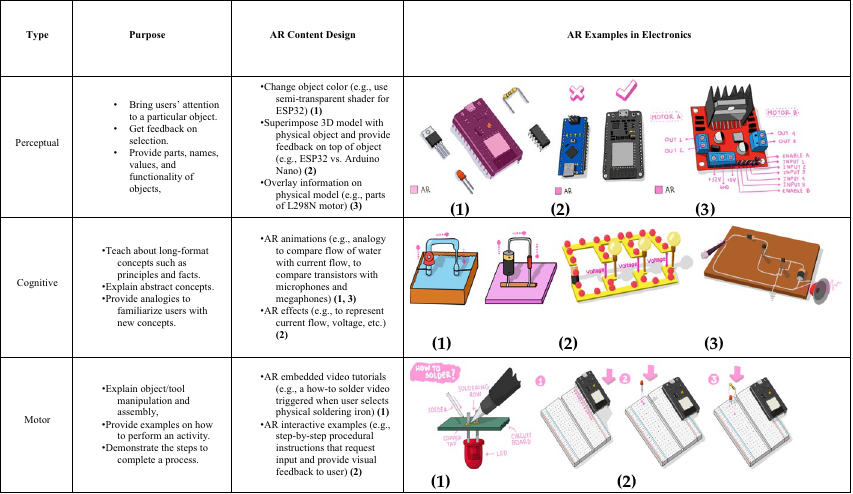
Table 1 Microskills aligned as AR content. AR content design principles based on the type of identified